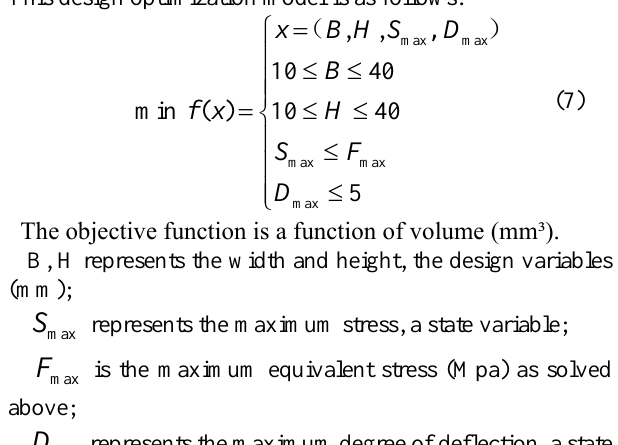
Figure 4. Model equivalent maximum stress curve Based on the changes of the value of the stress in different directions in Figure3, the maximum stress curve for the model can be drawn with ANSYS time mileage processor, which is shown in Figure4. Figure 3(a, b, c, d, e, f) can visualize the changes, maximum and minimum of the stress in all directions. The maximum equivalent stress of 30.844Mpa was obtained from the model in Figure 4, and was taken to be the optimized design